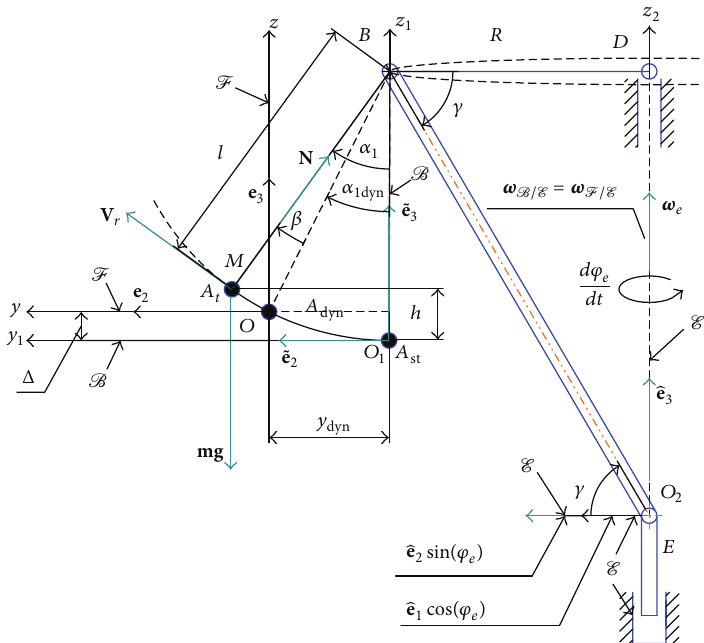
Figure 8: Swaying scheme of load 𝑀 on the cable 𝑀𝐵 , which is fixedly attached at the point 𝐵 on the crane boom 𝐵𝑂 2 , in the vertical plane ( 𝑦𝑧 ) for the nonlinear model derivation in Cartesian